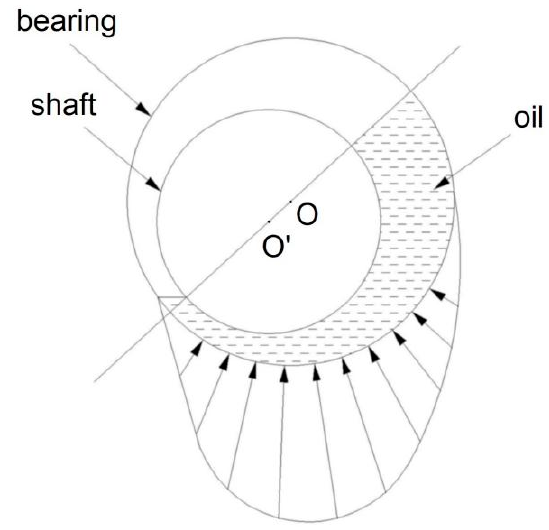
Figure 1. Schematic diagram of hydrodynamic lubrication.